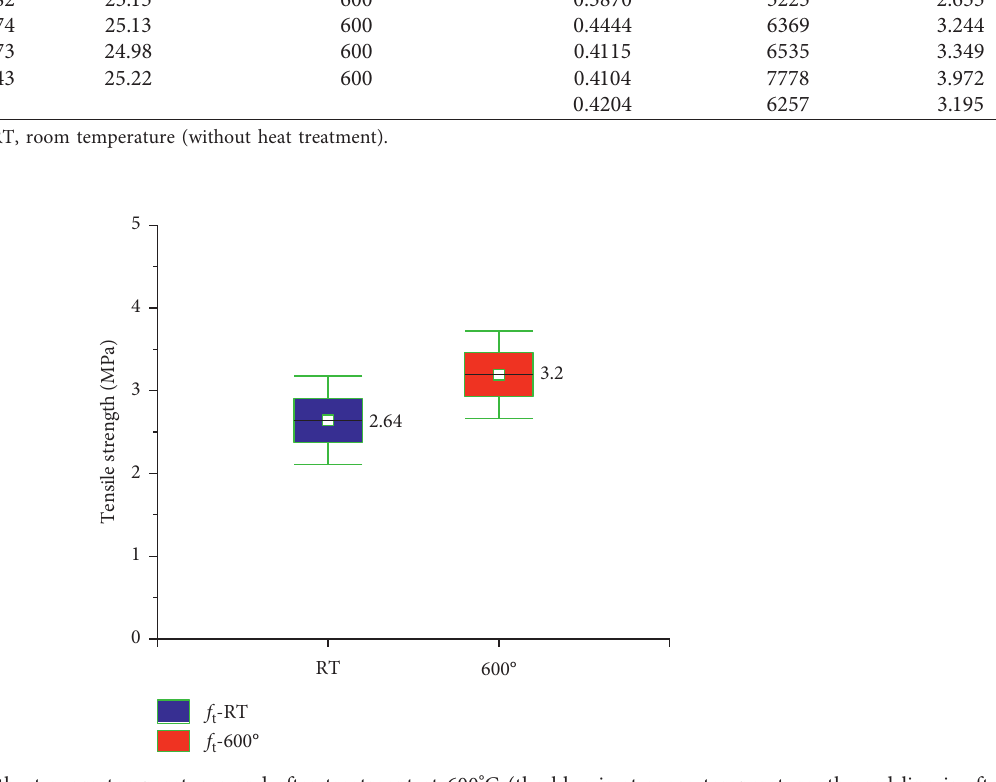
Figure 11: Tensile strength at room temperatures and after treatment at 600 ° C (the blue is at room temperature; the red line is after treatment at 600 ° C).